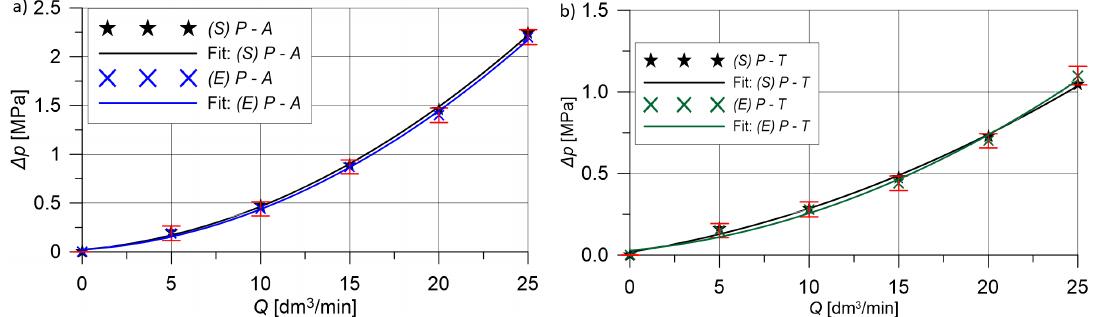
Figure 18. Comparison of simulation and experimental results of pressure drop; ( a ) P − A flow path, ( b ) P − T flow path; error bars—the measurement uncertainty. Table 3. Comparison of simulation ( S ) and experimental ( E ) values of pressure drop ∆ p MPa. Path